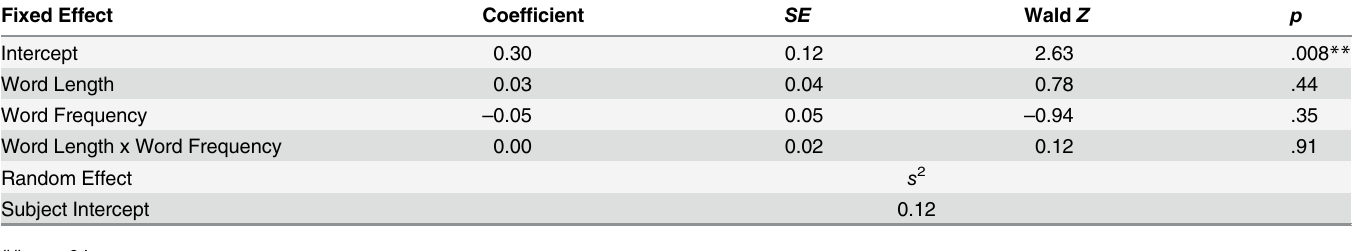
Table 7. Summary of logistic regression predicting the likelihood of a congruent name